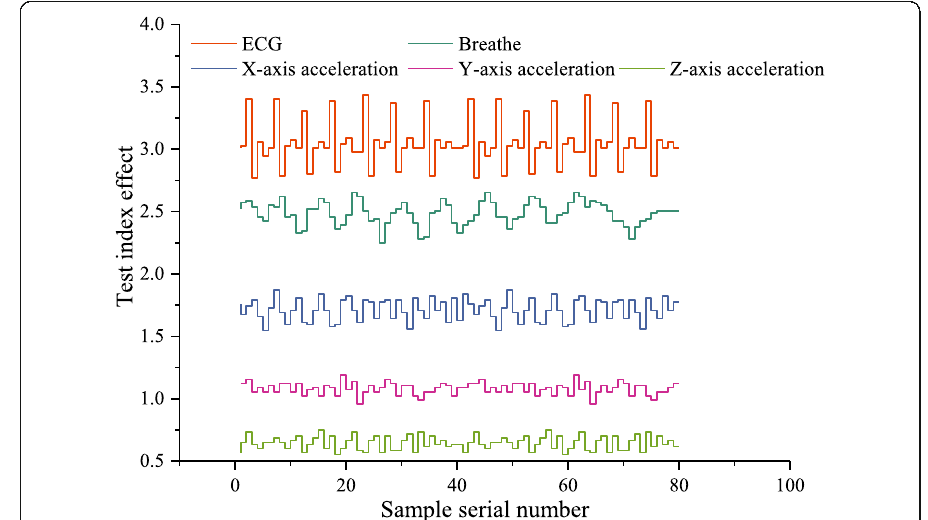
Fig. 5 Test values of cardiopulmonary physiological signals — exercise intensity 4